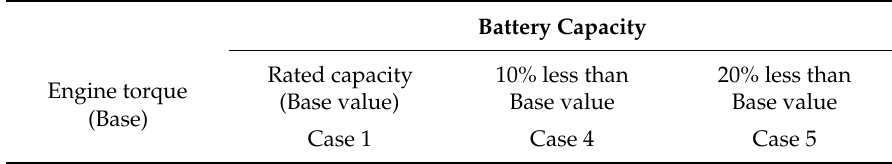
Table 5. Scenarios for battery-capacity variation with fixed engine torque in the numerical